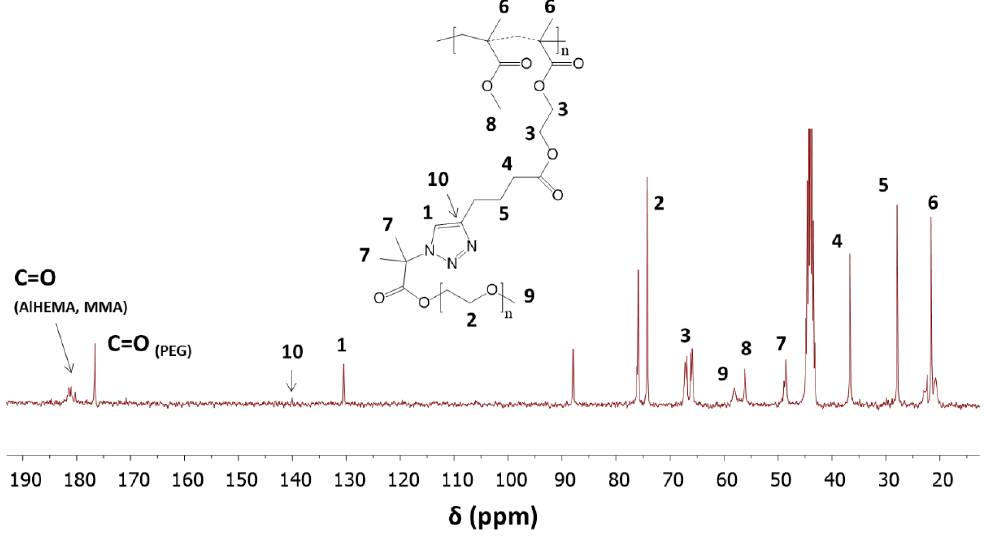
Figure 6. 13 C-NMR of graft copolymer P((HEMA- graft -PEG)- co -MMA) by “click” reaction.